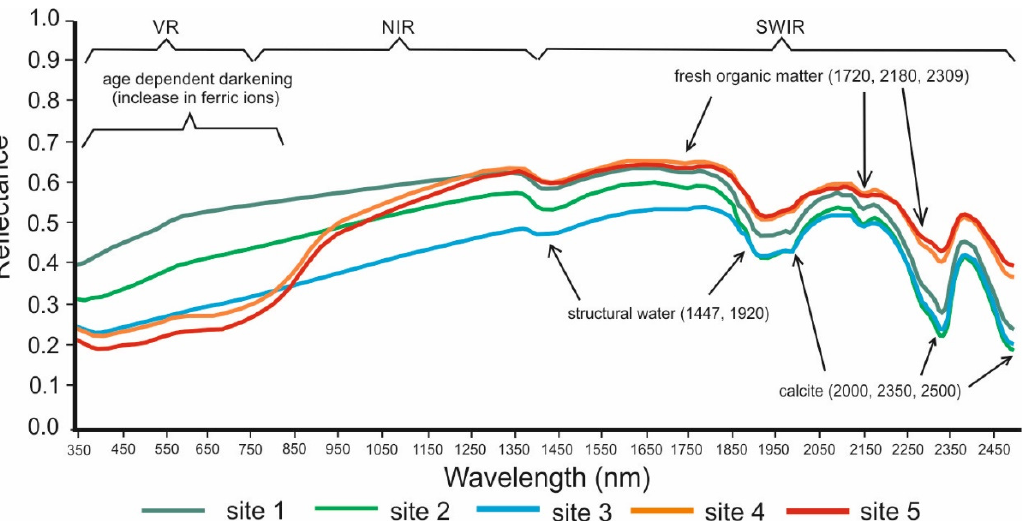
Figure 4. Re fl ectance spectra of the Dachstein limestone at the Hallstä tt er Glacier foreland. VR— Figure 4. Reflectance spectra of the Dachstein limestone at the Hallstätter Glacier visible radiation, NIR—near-infrared radiation, SWIR—short-wavelength infrared radiation.